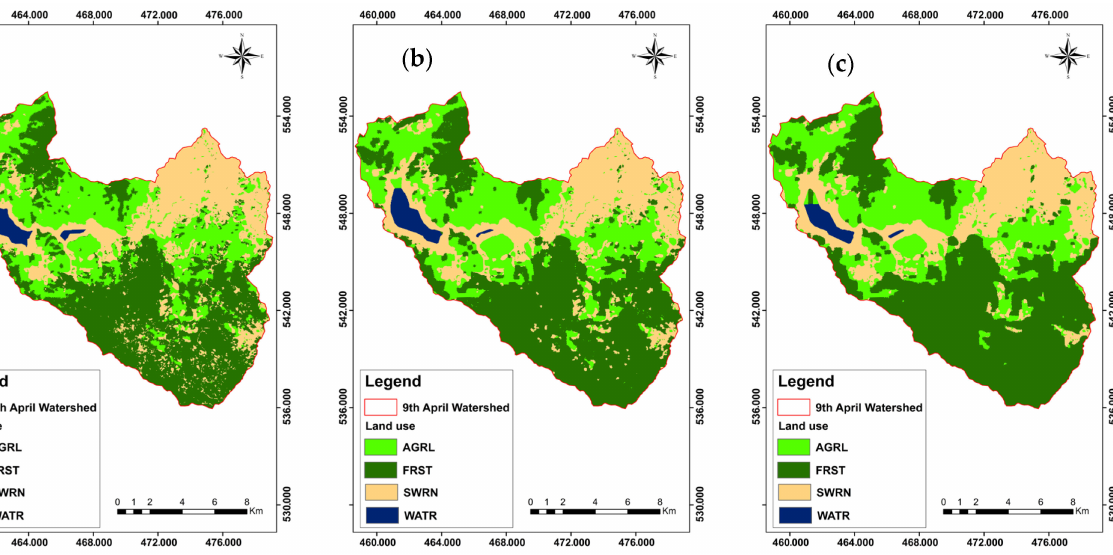
Figure 6. ( a ) 2028 projected land use; ( b ) 2038 projected land use; ( c ) 2050 projected land